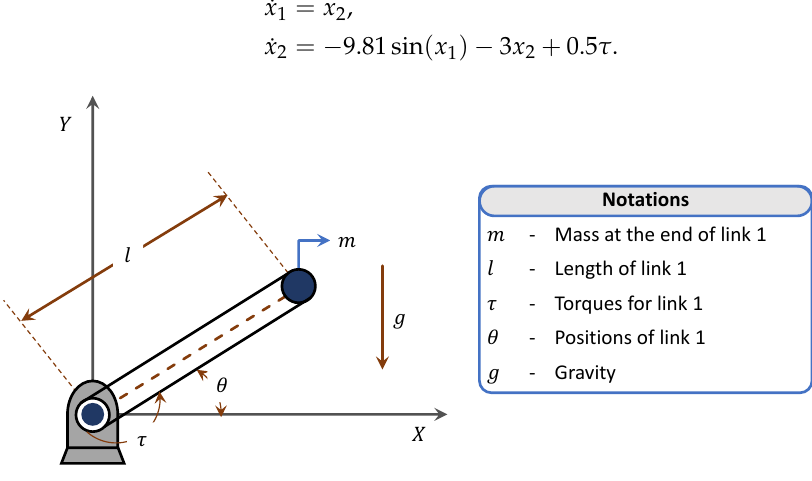
Figure 6. Single-link planar rigid robotic